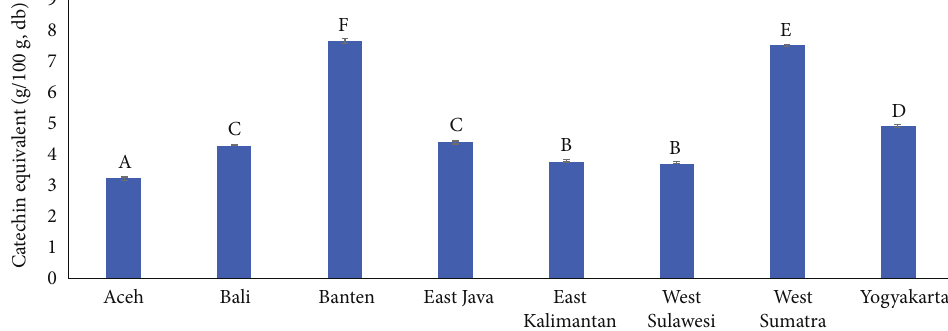
Figure 2: Total phenolic content of fermented cocoa bean from various regions in Indonesia. Bars with the same letter showed that the values were not signi fi cantly di ff erent (based on one-way ANOVA and Tukey ’ s HSD tests at 95% con fi dence